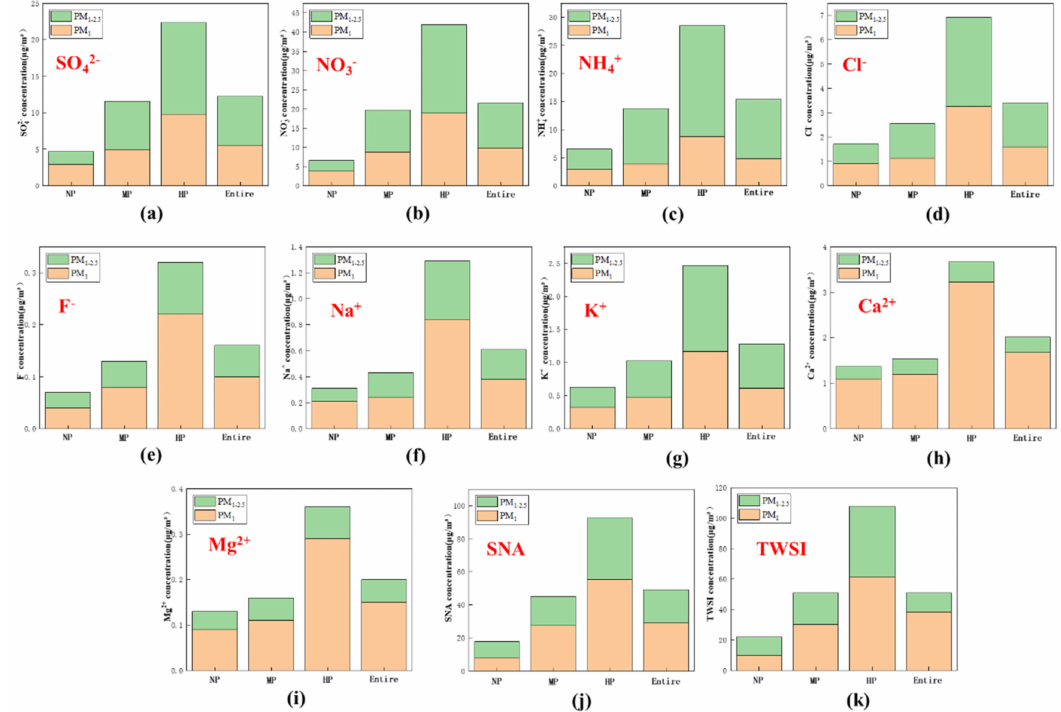
Figure 2. Concentrations of SO 42 − , NO 3 − , NH 4+ , Cl − , F − , Na + , K + , Ca 2+ , Mg 2+ , SNA, TWSI ( a – k ) in PM 1 and PM 1–2.5 on non-pollution, mild-moderate pollution and heavy pollution in Handan in the period from 15 October to 15 November 2017 and from 29 December 2017 to 26 January